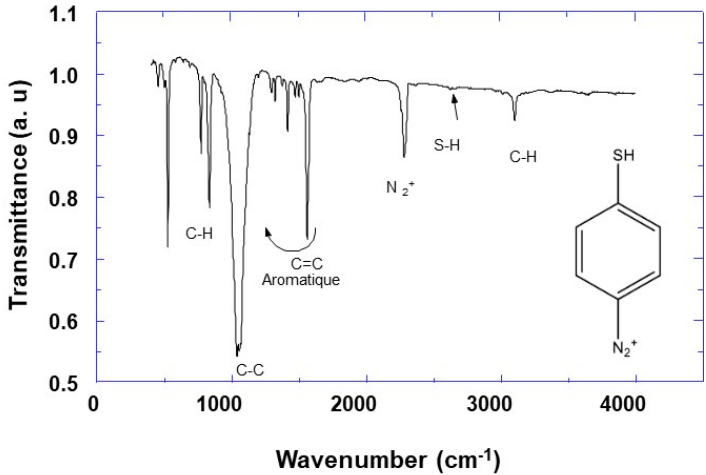
Figure 1. Infrared (IR) spectra of synthesized4-thiolphenyl diazonium salt (4-MPD).